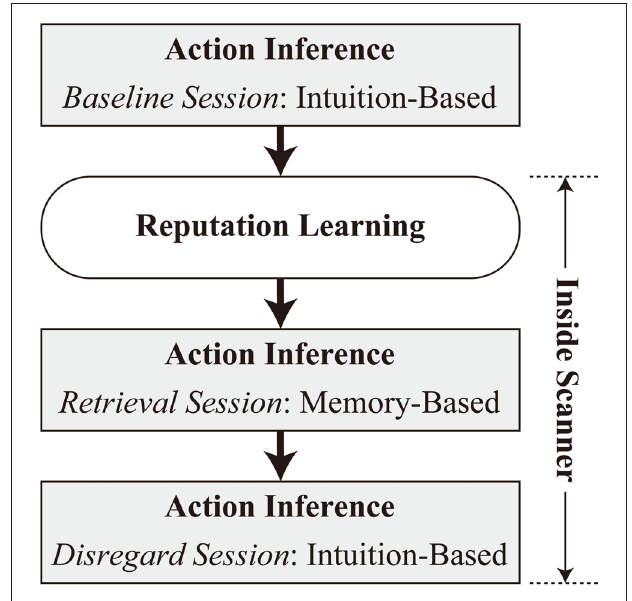
FIGURE 1 | Overview of the experimental procedure